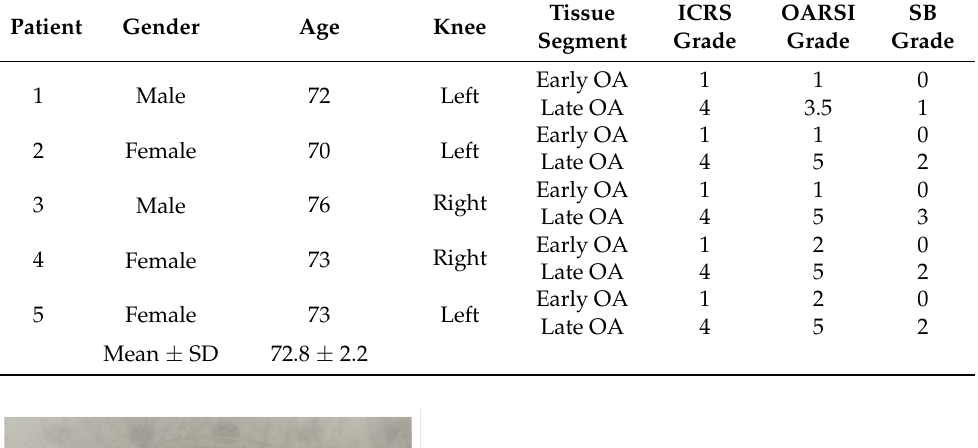
Table 1. Demographic information, macroscopic (ICRS Cartilage Lesion Grade) and histological scores (OARSI OA Cartilage Histopathology Grade and Subchondral Bone Histological Grade) of condyles obtained from patients undergoing TKR surgery.